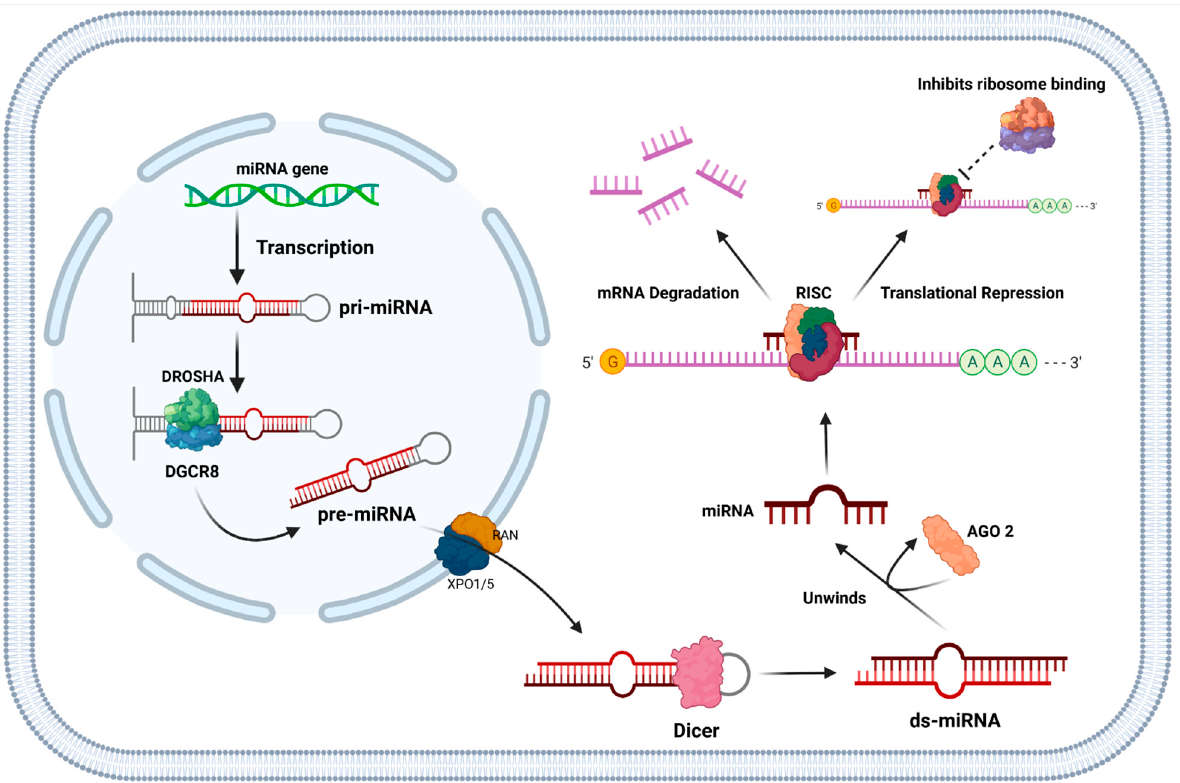
Figure 2. Synthesis and action of miRNA in post-transcriptional gene regulation. Transcription of miRNA gene via RNA Polymerase II forms pri-miRNA, DROSHA (class 2 ribonuclease III enzyme) and DGCR8 cleave the terminal end of the miRNA hairpin to form pre-miRNA. This is exported via RAN and XPO1/5. The miRNA hairpin is then cleaved by Dicer. AGO-2 binds to the double stranded miRNA, unwinds and dissociates the strands then forms a complex with RISC. This leads to either miRNA degradation or inhibition of ribosome binding. Abbreviations: pri-miRNA: primary- miRNA, pre-miRNA: precursor-miRNA, DGCR8: DiGeorge syndrome critical region gene 8, XPO 1/5: Exportin 1/5, RISC: RNA-induced silencing complex. (Created with BioRender.com, accessed on 16 January2022.)